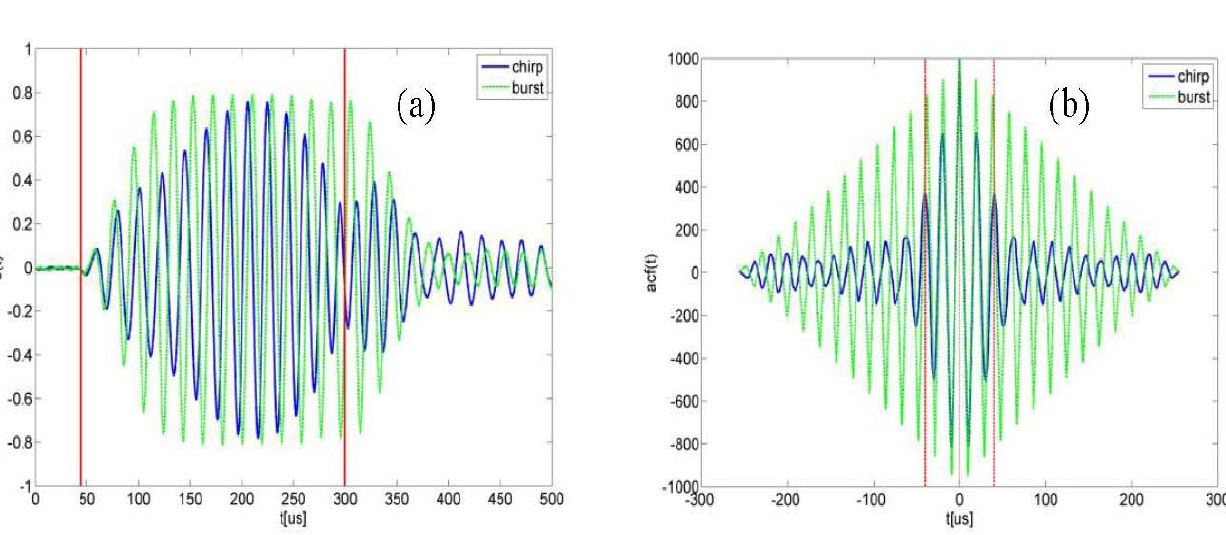
= 52.5 kHz and chirp with 0